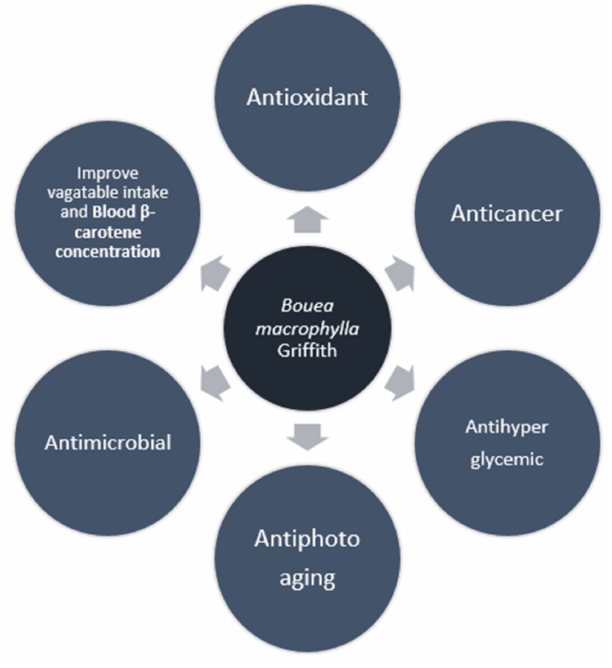
Figure 3. A summary of the pharmacological activities of B. macrophylla